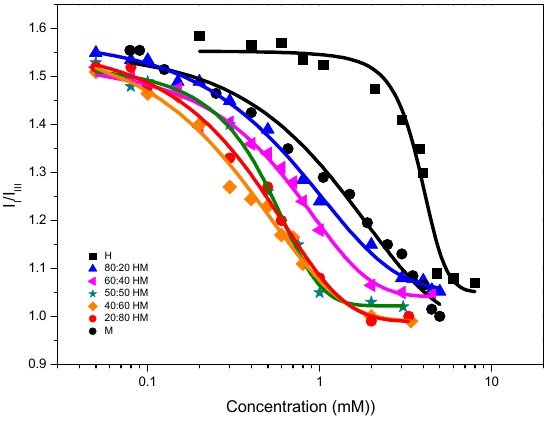
Figure 4. I I / I III ratio obtained from pyrene fluorescence in the presence of the pure surfactants and the catanionic